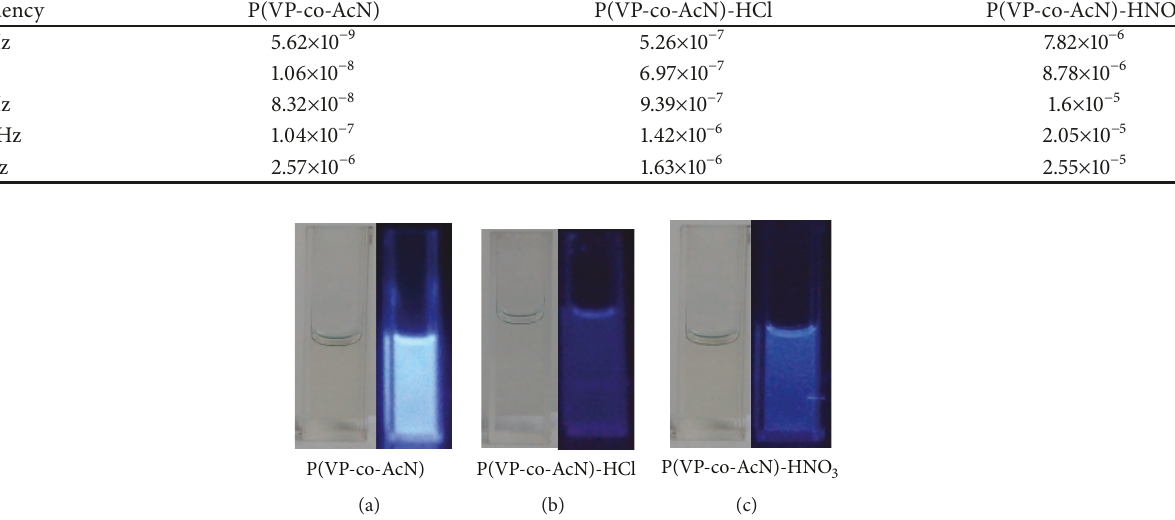
Figure 10: Photographic images of P(VP-co-AcN) (a), P(VP-co-AcN)-HCl (b), and P(VP-co-AcN)-HNO 3 (c) under normal light and UV light, respectively.